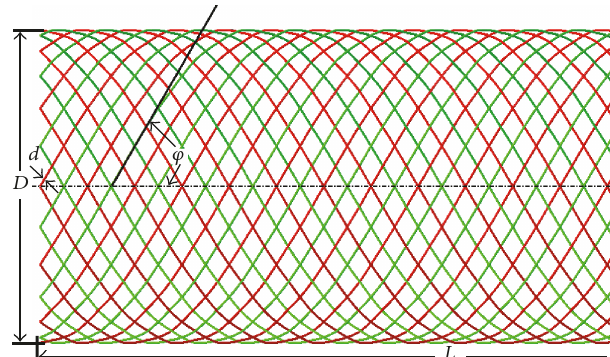
Figure 2: 3D model of braided wire stent ( D , nominal diameter of stent; d , strand diameter; L , nominal stent axial length; φ , braiding angle).